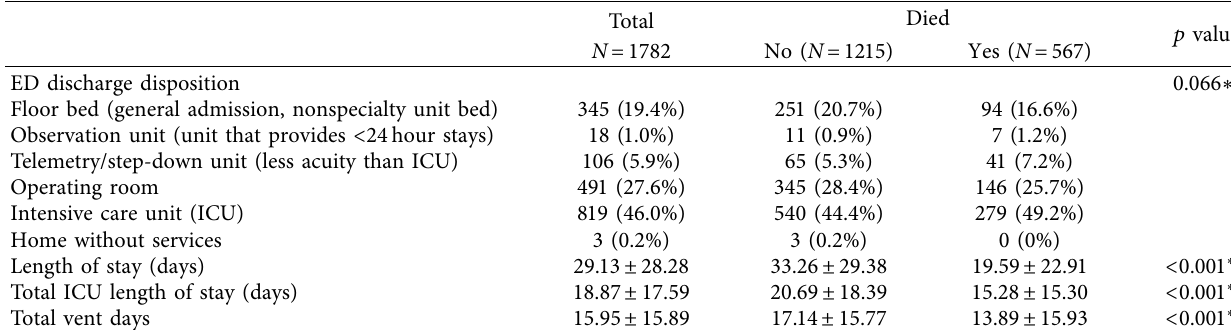
Table 5: Table showing the hospital outcomes of the trauma patients who developed sepsis during their hospital